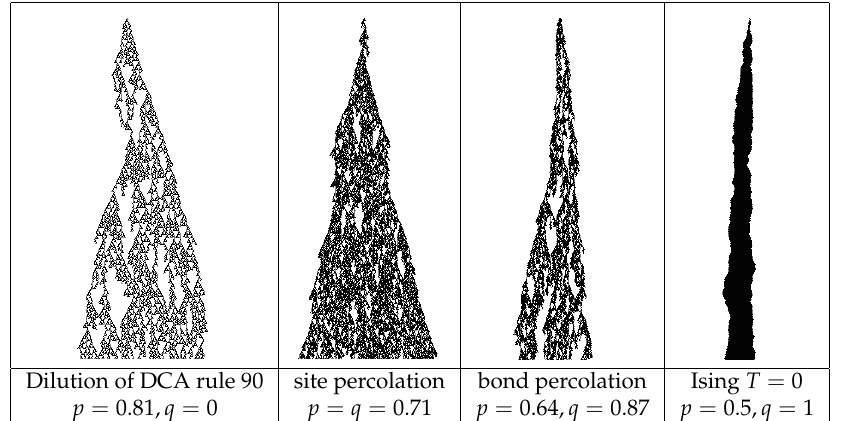
Figure 7. Typical patterns of the DK model. Space runs horizontally and time vertically, from top to bottom. Figures from